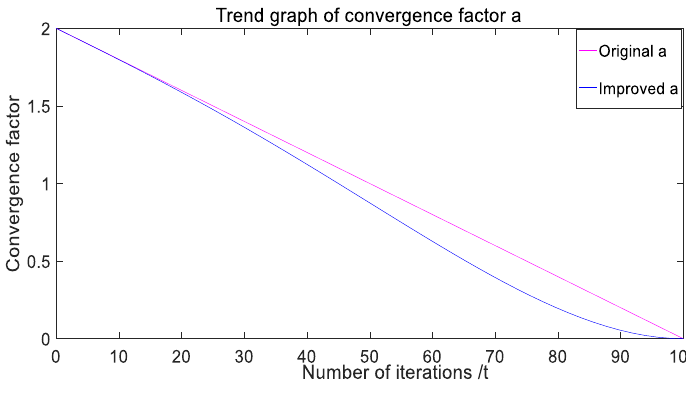
Figure 1. Convergence factor comparison chart.